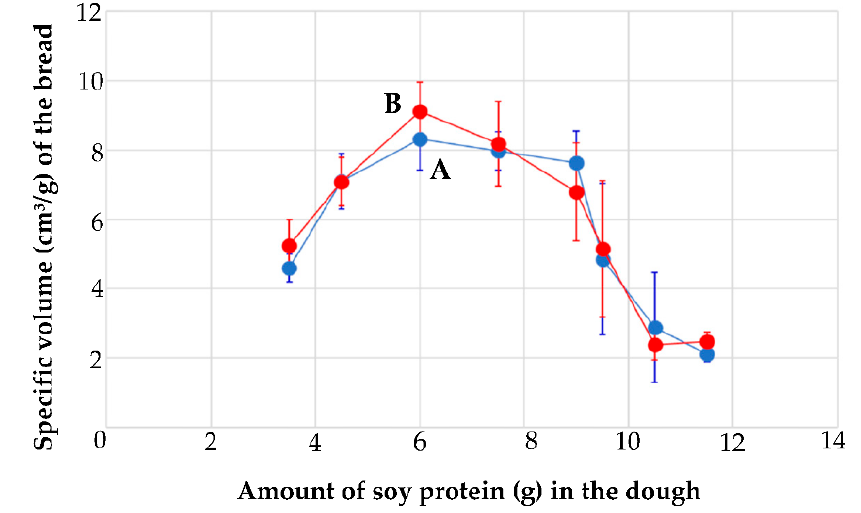
Figure 3. Specific volume (cm 3 /g) of the bread made of soy protein and egg white protein. Horizontal axis shows the amount (g) of soy protein added to 22.5 g of a raw egg white in making the dough. (A) No starch and (B) cornstarch (2.5 g) were added to the dough, respectively. Reprinted/adapted with permission from Ref. [23]. Copyright 2021, NARO.